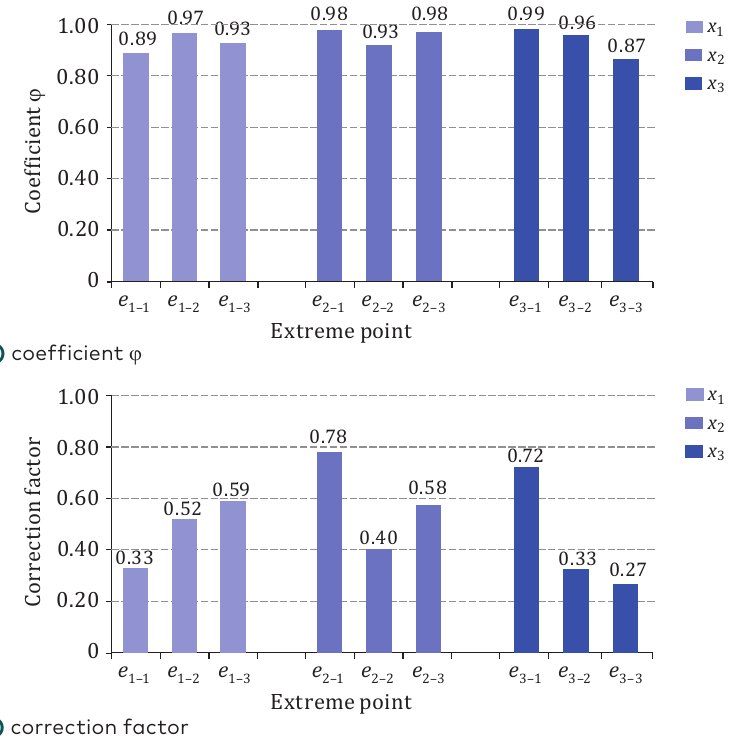
b) correction Figure 20. Calculated coefficient j and correction factor